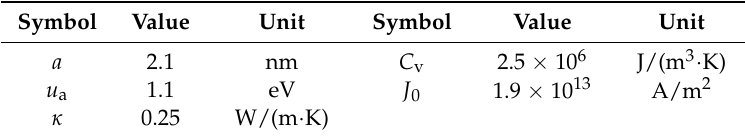
Table 1. Parameters for thermal breakdown simulation.